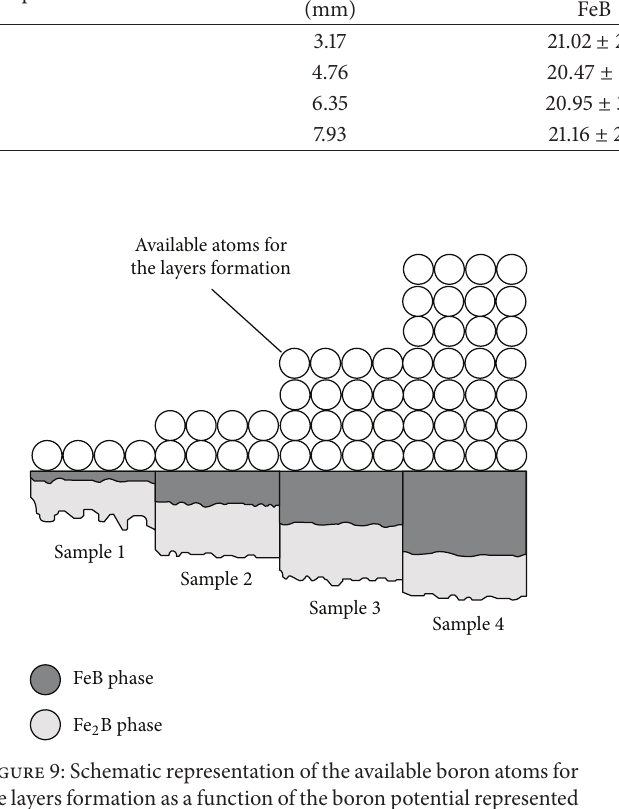
Figure 9: Schematic representation of the available boron atoms for the layers formation as a function of the boron potential represented by the inner diameter of the samples.